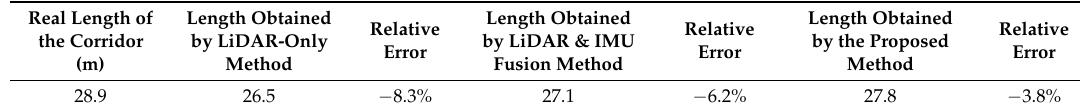
Table 1. Error Comparison in Open Loop.